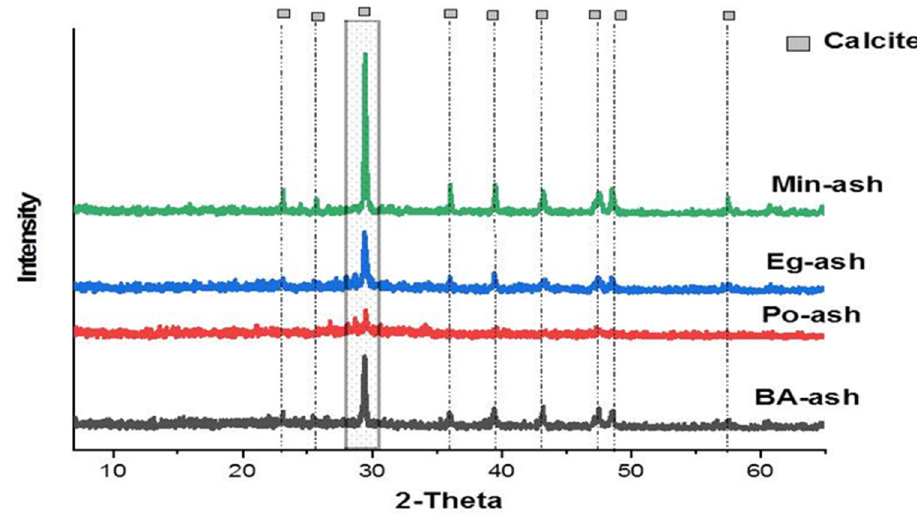
Figure 6. XRD of CaCO 3 precipitating in the residue of agro-ash material presenting in the calcite phase.